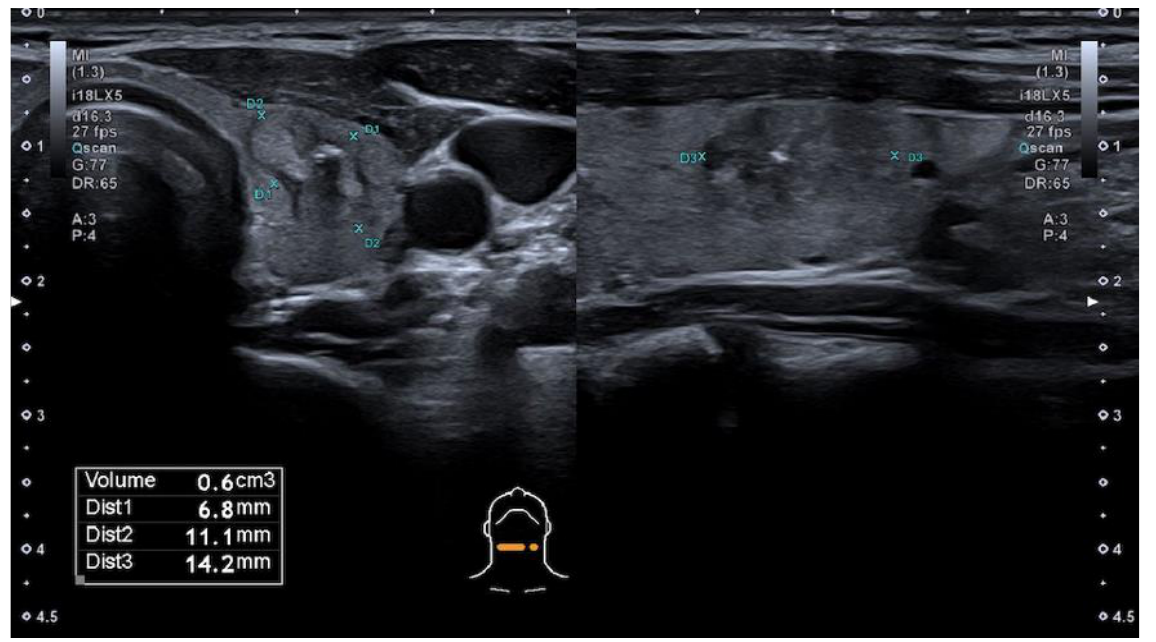
Figure 2. Hypoechogenic nodule, ovoid shape, smooth margins, non-homogeneous solid thyroid nodule with cystic component and macrocalcification in its structure—TIRADS 3 by modified Kwak et al. (L-TIRADS), TIRADS 4 by European and Korean TIRADS, TIRADS 5 by ACR TIRADS systems. FNA biopsy results — Bethesda 2.